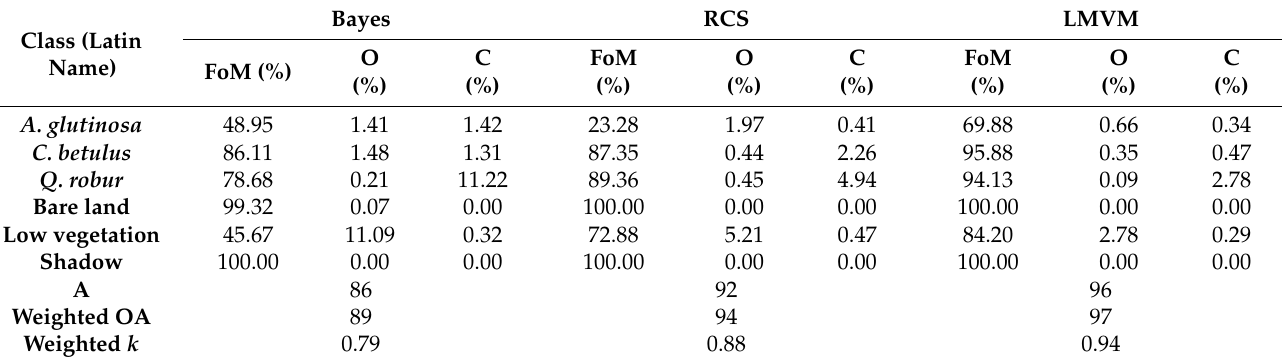
merit (FoM) accuracy metrics indicate that object-based classification, in comparison to pixel-based approach, improved classification accuracy. Table 5. Extended accuracy assessment of object-based classification of the pansharpened imageries (Bayes, RCS, LMVM). Class (Latin Name)